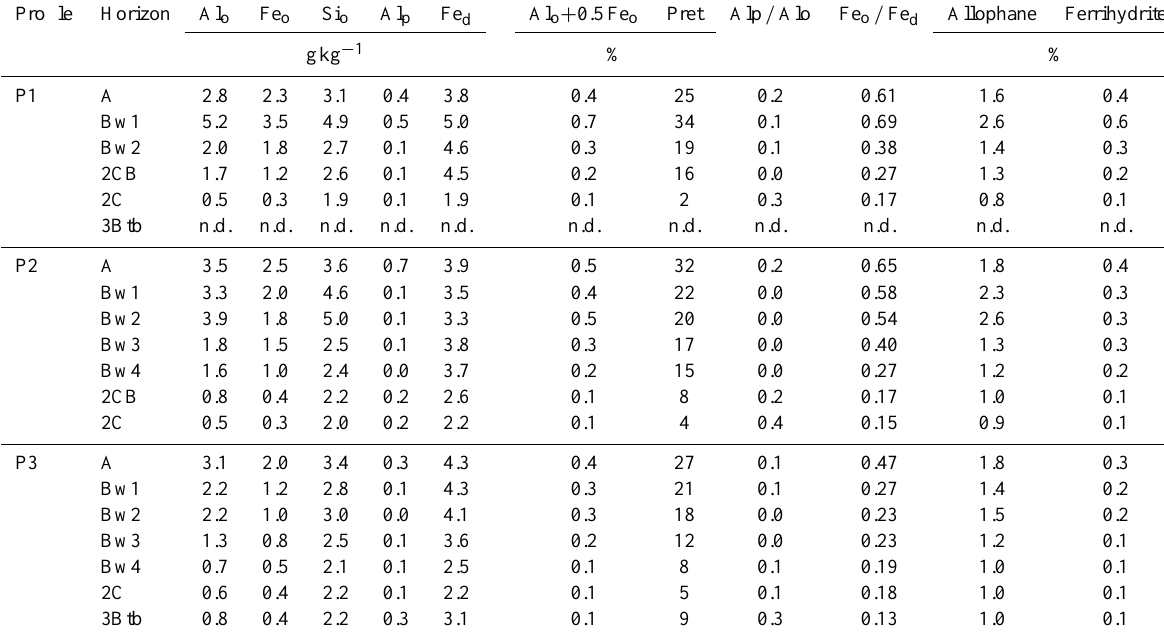
Table 3. Selectively dissolved elements (Al, Fe, Si) measured by ICP AES.